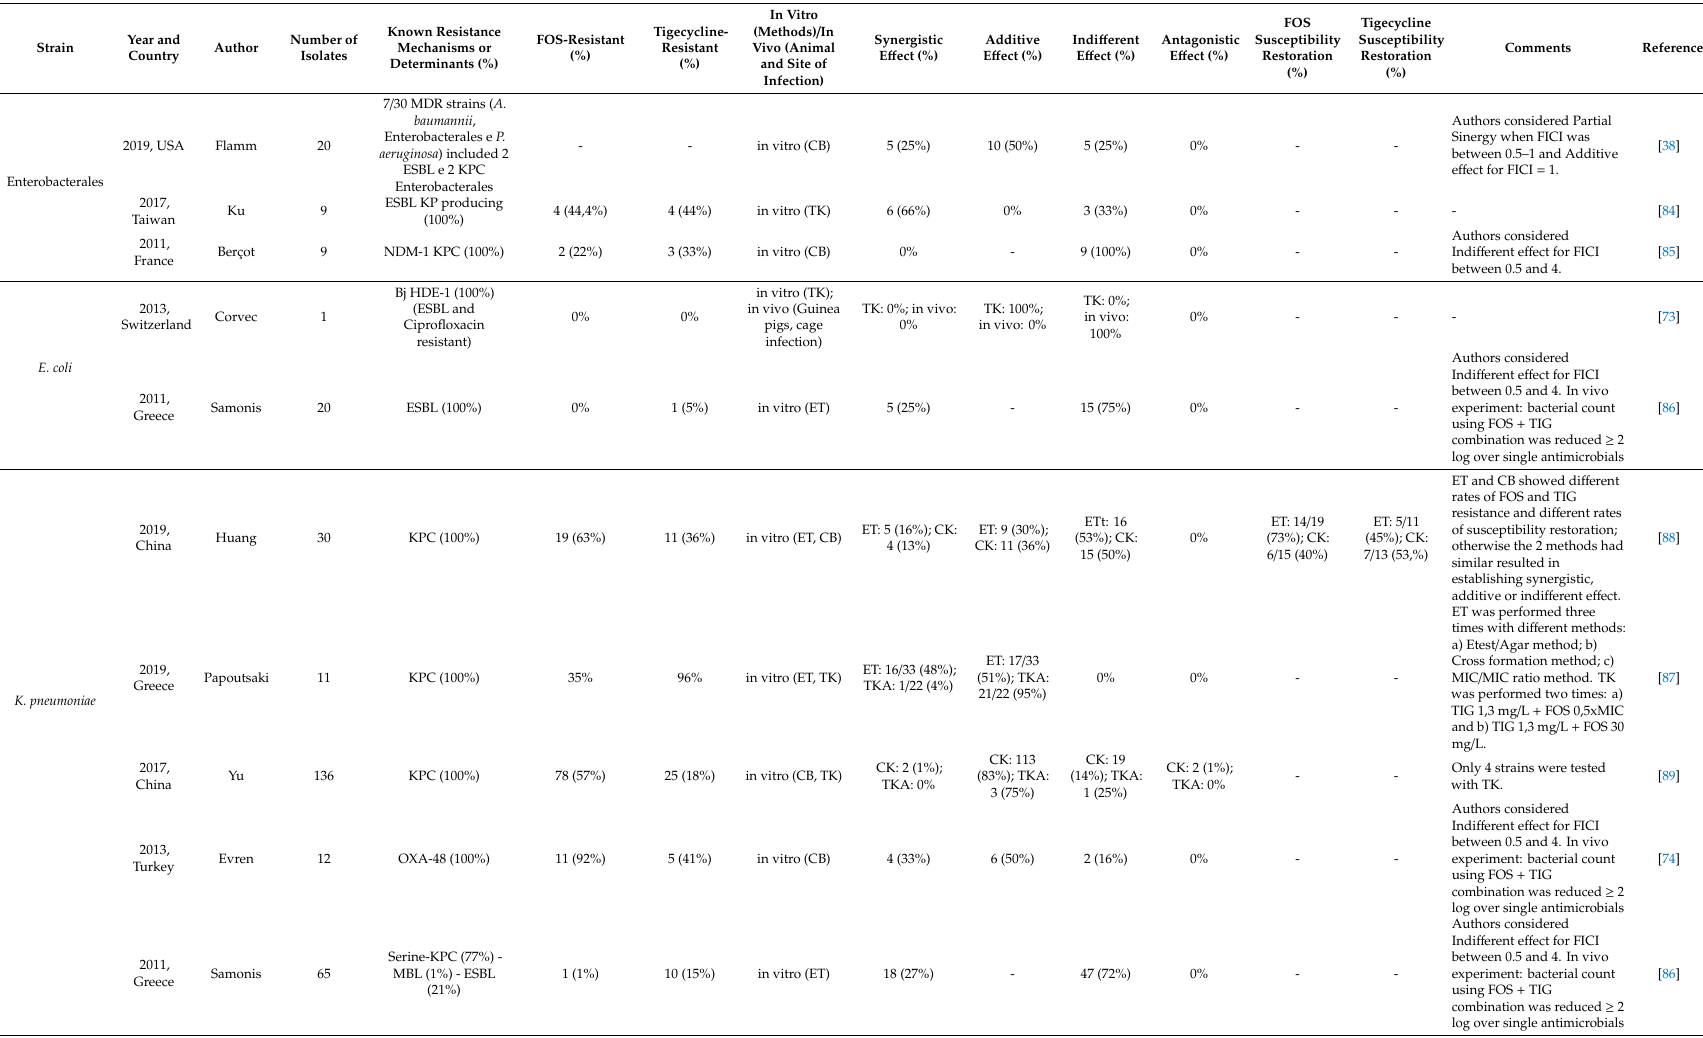
Table 12. Studies on combination between fosfomycin and tigecycline. CB: checkerboard assay; TK: time–kill assay; ET: